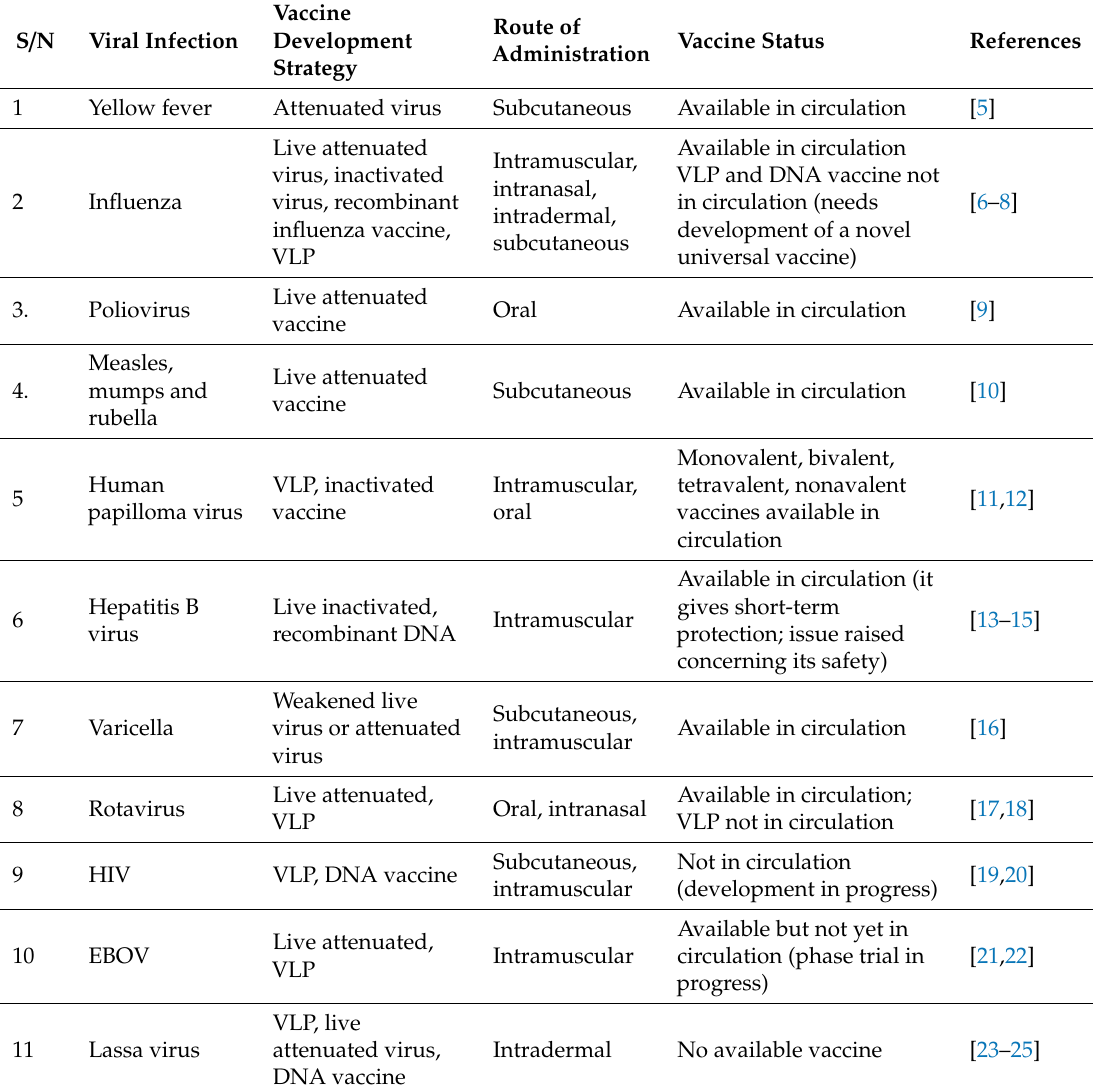
Table 1. Vaccine development strategies for selected viral